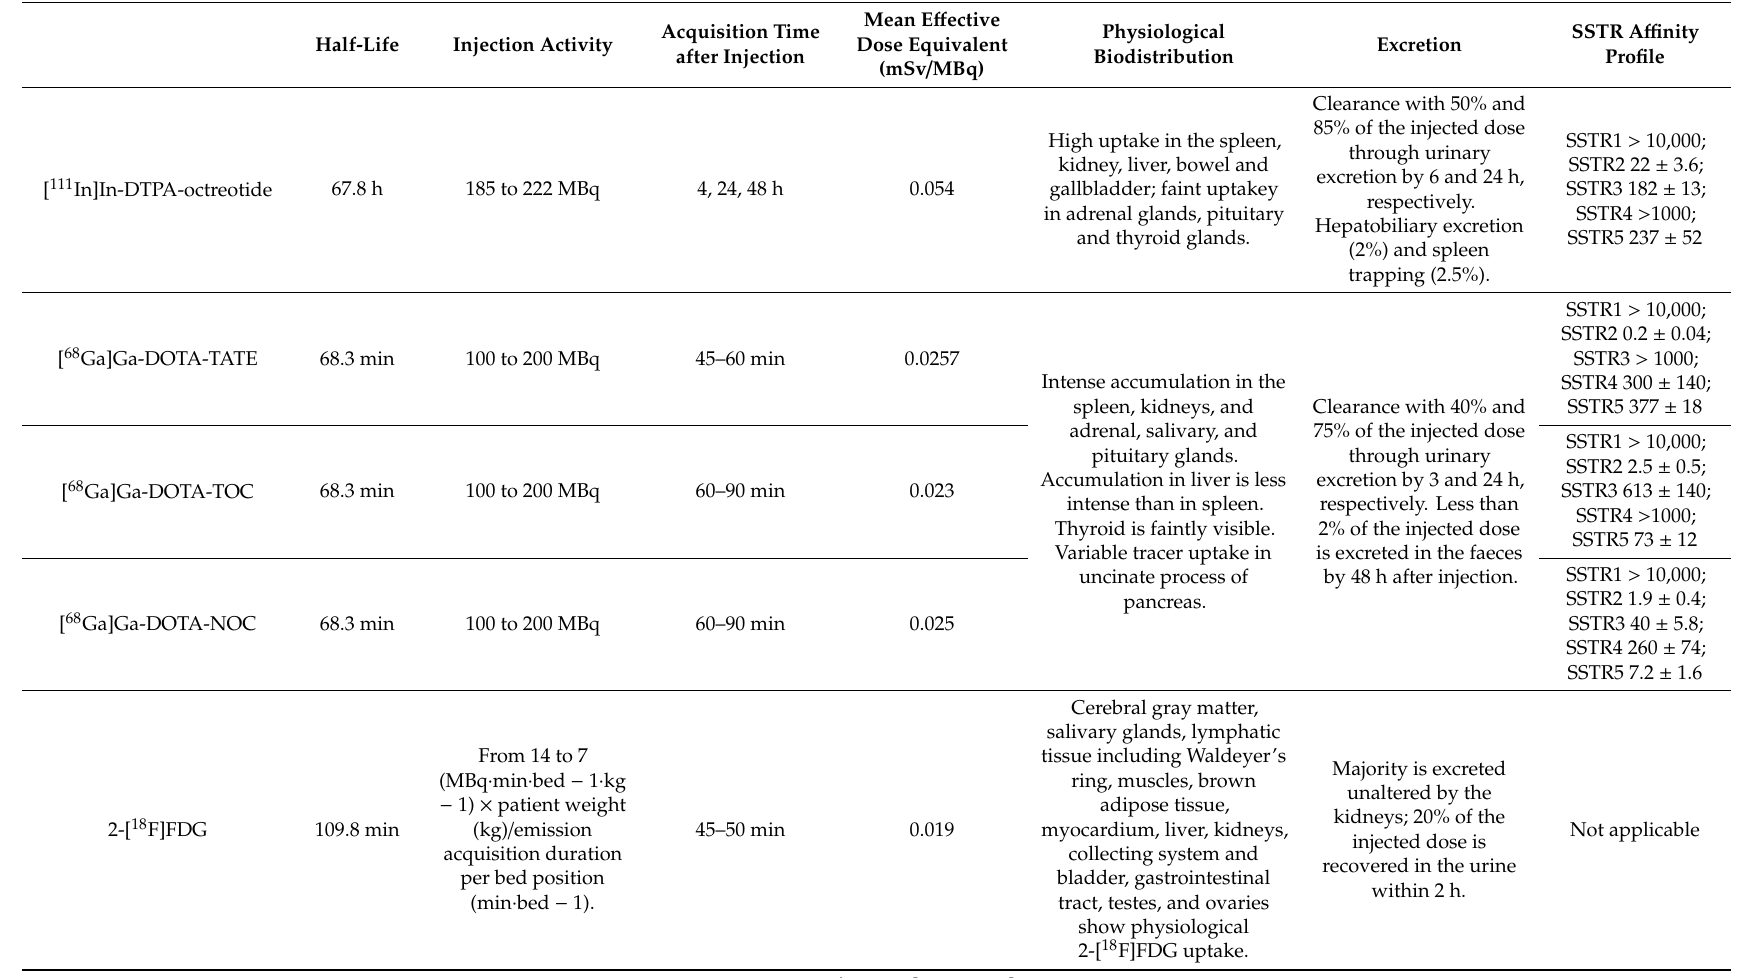
Table 4. Characteristics of the clinically most widely used radiotracers for functional imaging of NENs in adult